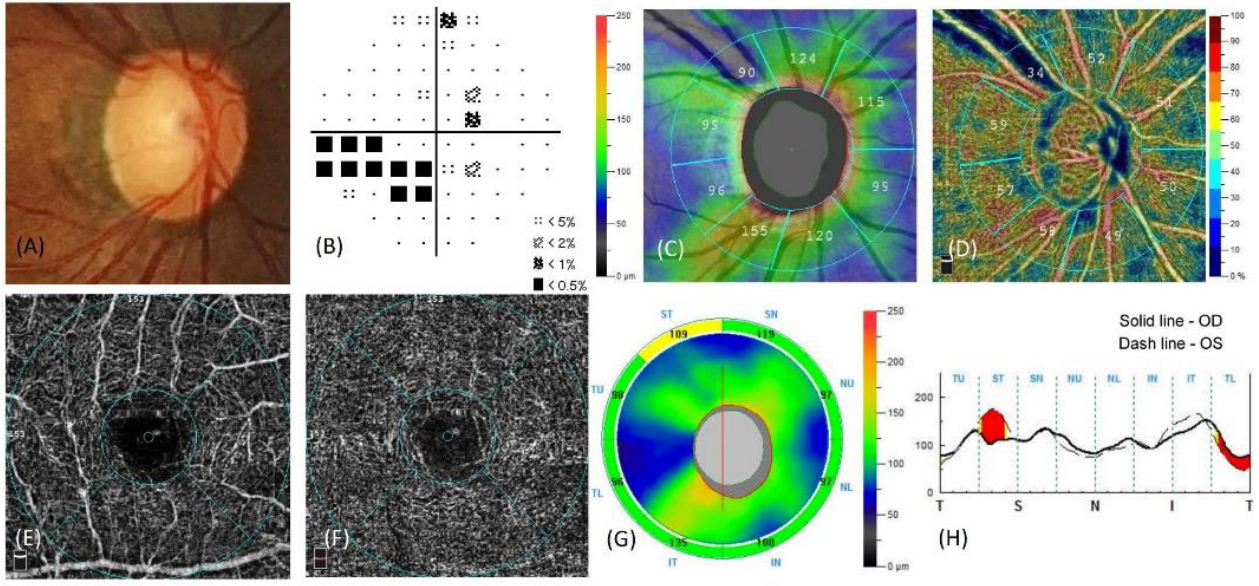
Figure 1. Representative case of a normal-tension glaucoma eye treated with carteolol (right eye). ( A ) The color photograph shows superior-temporal rim thinning of the optic disc. ( B ) The 30–2 Swedish interactive threshold algorithm standard pattern deviation image obtained using the Humphrey Visual Field Analyzer shows inferior-nasal step visual field defects (visual field mean deviation: − 6.54 dB). ( C ) The circumpapillary retinal nerve fiber layer thickness map shows thinning at the superior-temporal regions. ( D ) The OCTA vessel density image shows apparent microvascular reduction at superior-temporal regions around the optic disc. ( E ) The superficial layer of the retina was measured in the 3.0 × 3.0-mm region centered on the fovea. The boundary of the superficial retinal layer extends from the internal limiting membrane to the inner plexiform layer. ( F ) The deep retinal layer measured in the 3.0 × 3.0-mm region centered on the fovea. The boundary of the deep retinal layer extends from the inner to outer plexiform layers. ( G ) The retinal nerve fiber layer (RNFL) thickness map shows decreased RNFL thickness at the superior-temporal sector. ( H ) Significantly decreased RNFL thickness compared with the fellow eye at the superior-temporal sector.